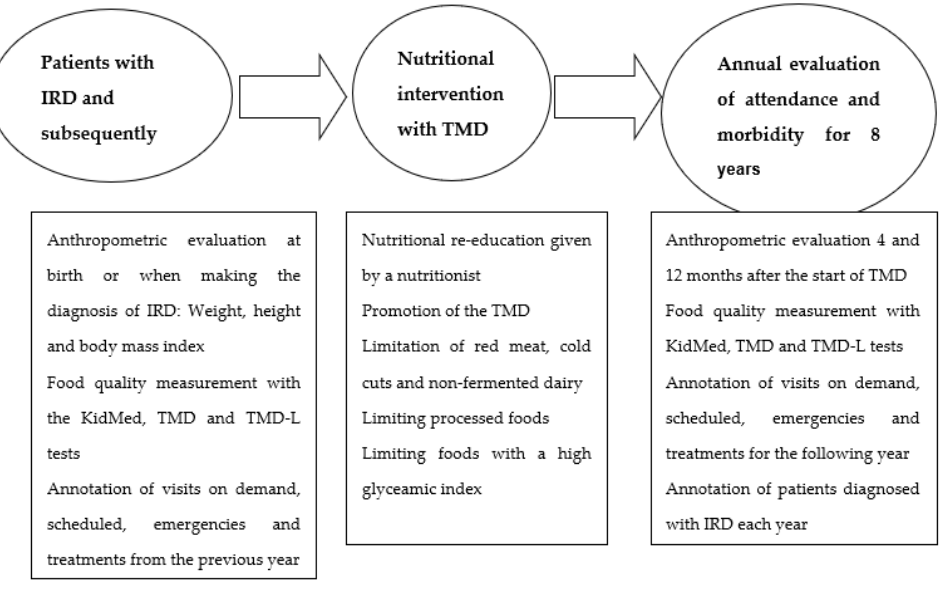
Figure 1. Study design diagram.